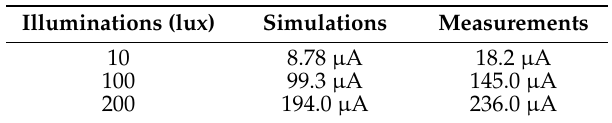
Table 2. Simulated and measured total currents versus illumination (lux) of the proposed CA with enhanced dark current cancellation.